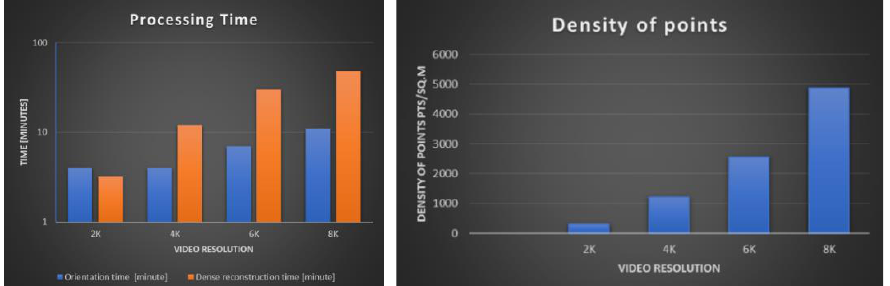
Figure 14. ( left ) The relation between the video frame resolutions and the consumed time for processing using a logarith- mic scale. ( right ) The relation between the video resolution and the point densities of the second experiment.